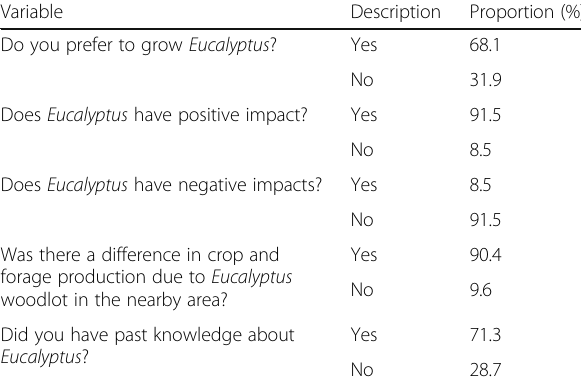
Table 3 Local people ’ s knowledge on Eucalyptus woodlot in Gudo Beret